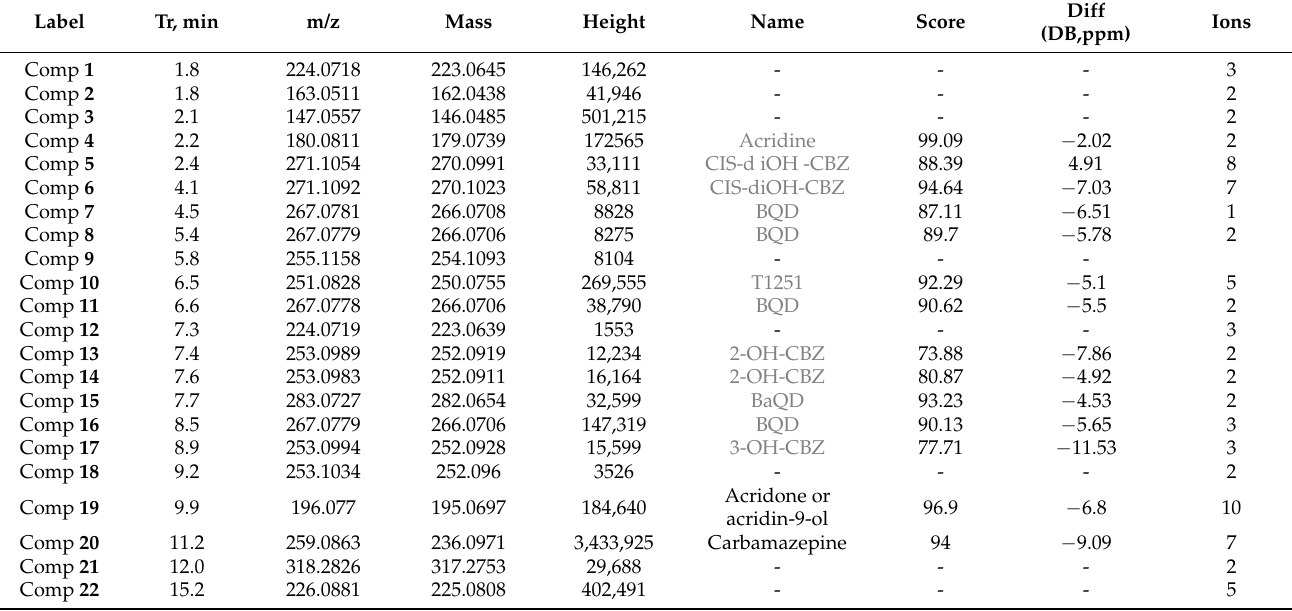
Table A1. Results of screening of major compounds. Sample pH = 2.0. Experimental conditions: [CBZ] = 50.0